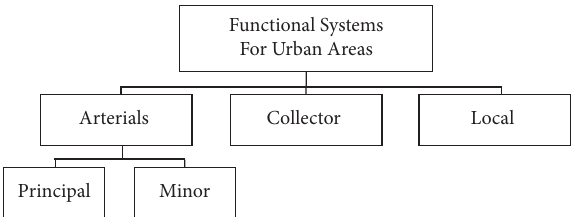
Figure 1: Functional system for urban areas schematic